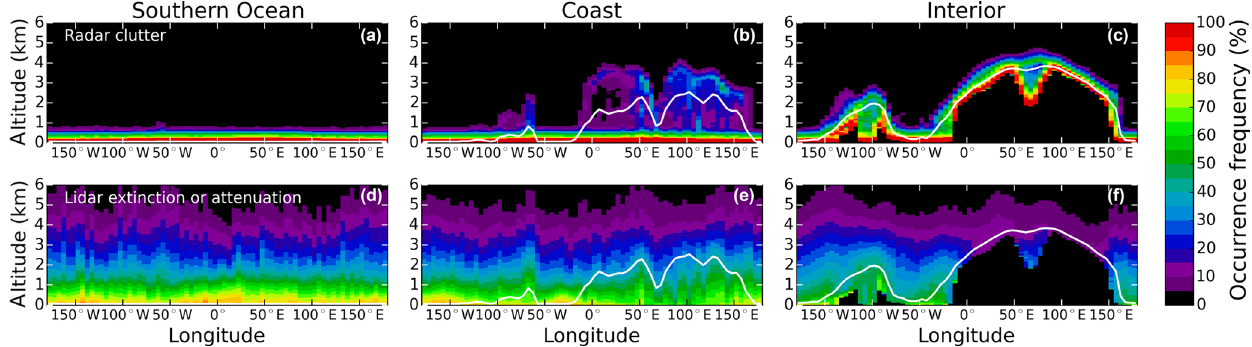
Figure A1. Vertical transects (2007–2010 average) showing the occurrence frequency (%) of the radar clutter contamination (a–c) and the lidar signal extinctions or attenuations (d–f) . The transects are averaged over the three latitudinal bands presented in Fig. 4d, namely the Southern Ocean (a, d) , the coast (b, e) and the interior (c, f) . The data are plotted for the summer season.